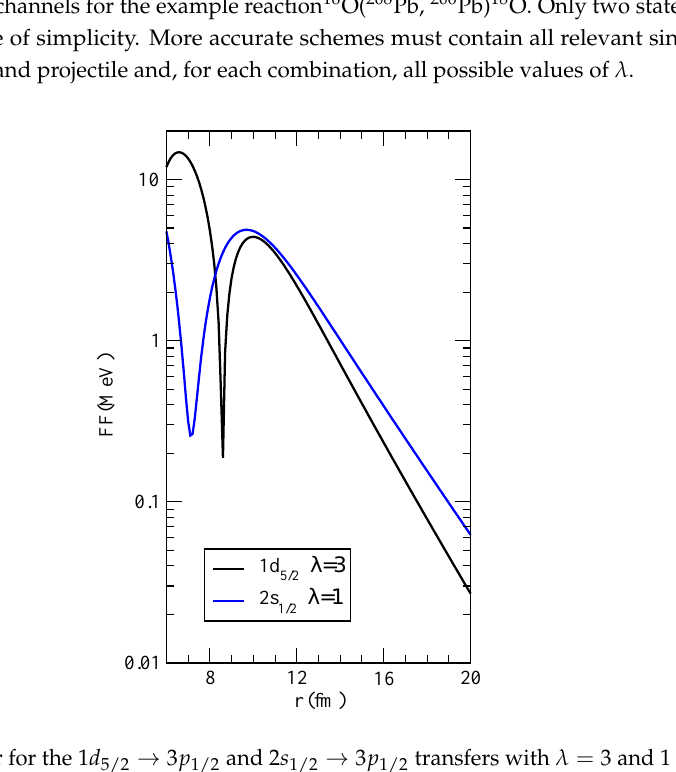
Figure 3. Form factor for the 1 d 5/2 → 3 p 1/2 and 2 s 1/2 → 3 p 1/2 transfers with λ = 3 and 1 respectively as a function of the ion-ion distance r